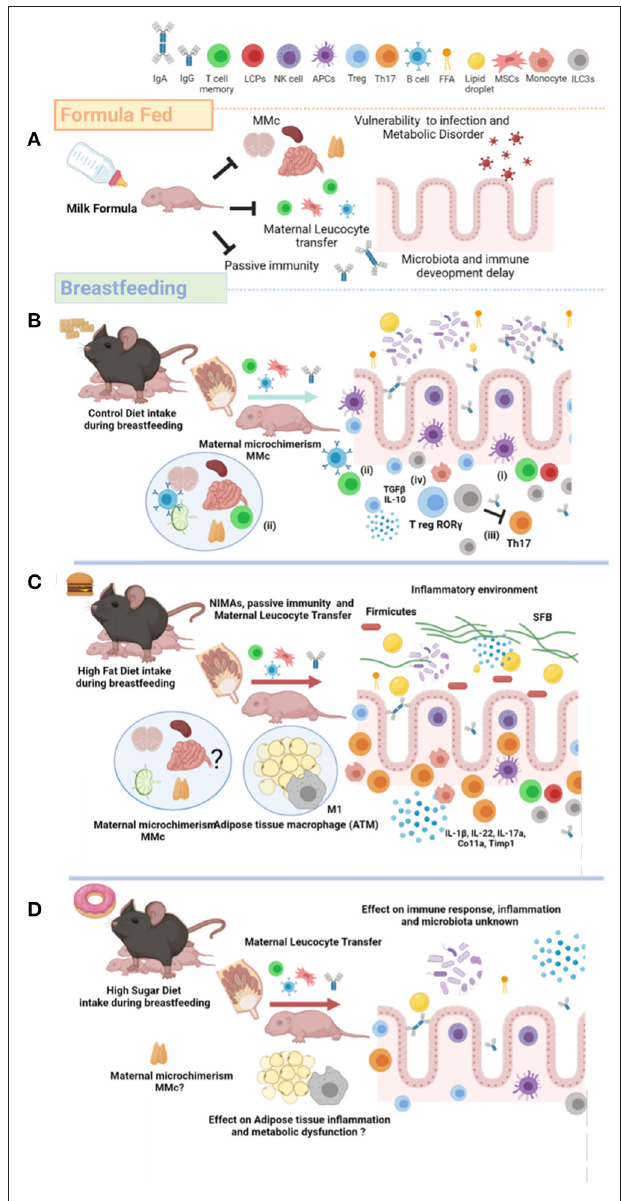
FIGURE 2 | Maternal nutrition modulates breastfeeding composition and metabolic failure in the newborn. (A) Artificial milk feed formula does not promote innate and adaptative immune activation, maternal MMc, and gut microbiome development in the newborn. Defective immunological system leads to offspring vulnerability against viral and bacterial infection. (B) Breastfeeding from lean mothers or healthy maternal nutrition induce maternal antibodies (passive immunity), NIMAs, and leucocyte maternal transfer. Additionally, breastfeeding favors several cell mechanisms involved in immunogenic tolerance: (i) altered antigen presenting, (ii) specific T- and B-subtypes on MMc, (iii) Th17 cells suppression by ILC3s, and (iv) accumulation of T-regulatory cells and microbiota invasion. (C) HFD exposure during breastfeeding reduces ILC3s and Treg, and increases the TH17 I the gut. Breastfeeding of mothers exposed to HFD also increase the inflammatory cytokine profile, and SFB colonization and firmicutes in the gut of newborn. Also, HFD exposure during breastfeeding increases the M1/M2 macrophages ratio in adipose tissue (ATM). The effect of high fat diet (HFD)